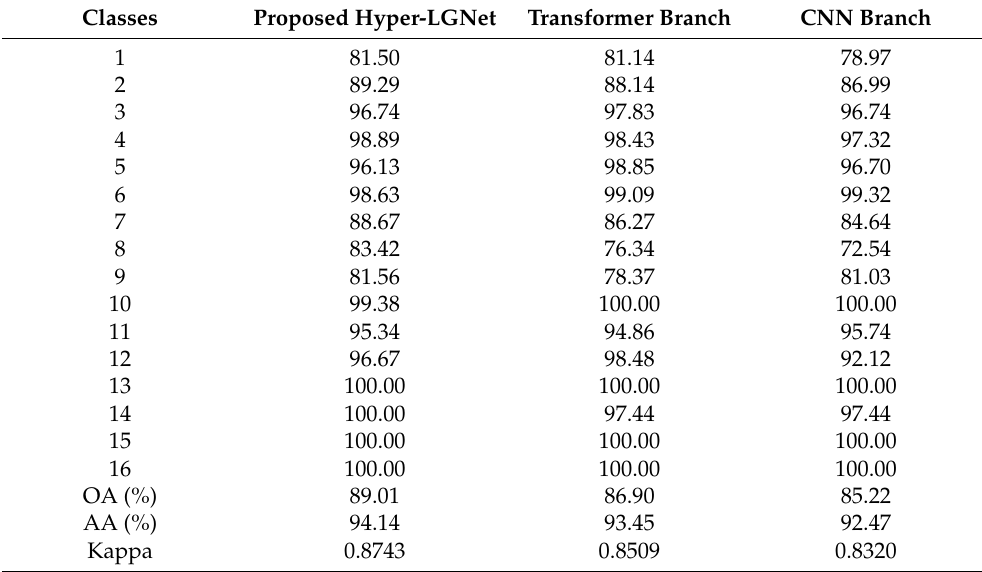
Table 9. Ablation study of various branches on Indian Pines